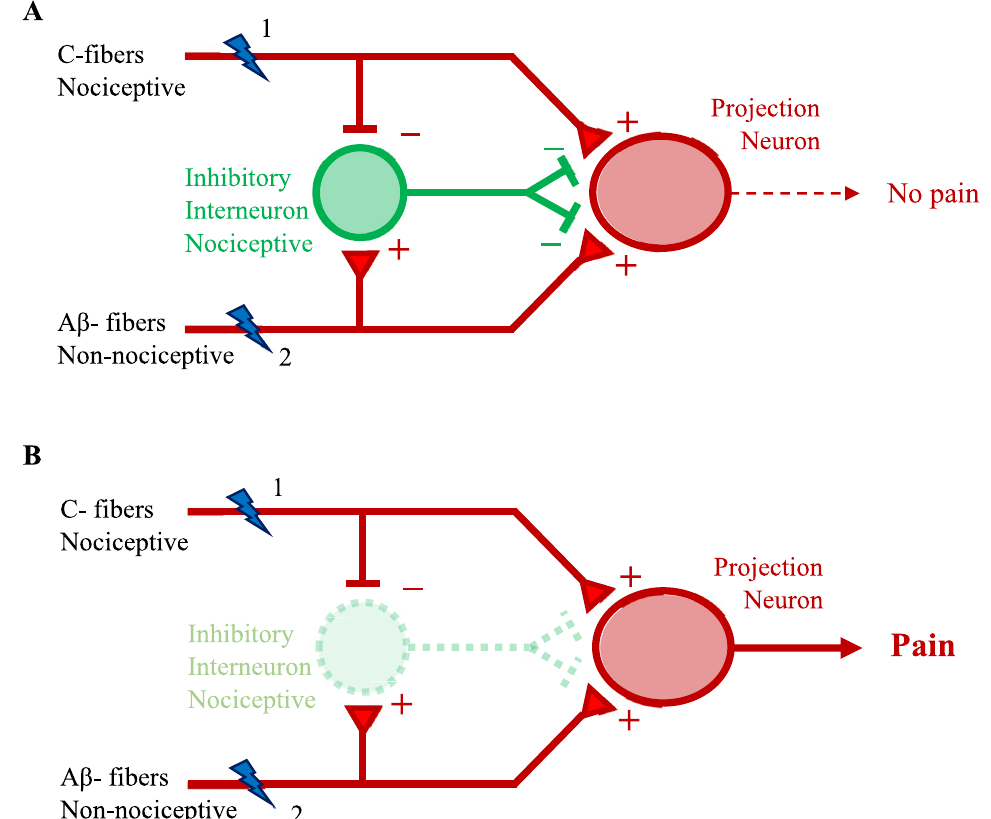
Fig. 3 Forward inhibition and allodynia. Nociceptive and non‑nociceptive signals are summated in nociceptive projection neurons, providing a control gate (Wall 1978) defining the input of signals to the brain. Transmission of pain signals is modulated by inhibitory glycinergic and/or GABAergic interneurons. A Under normal conditions, simultaneous activation of pain (1) and touch (2) receptors does not lead to pain sensation. B In case of inactivation of inhibitory interneurons (disinhibition), even tactile stimuli alone (2) lead to sensation of